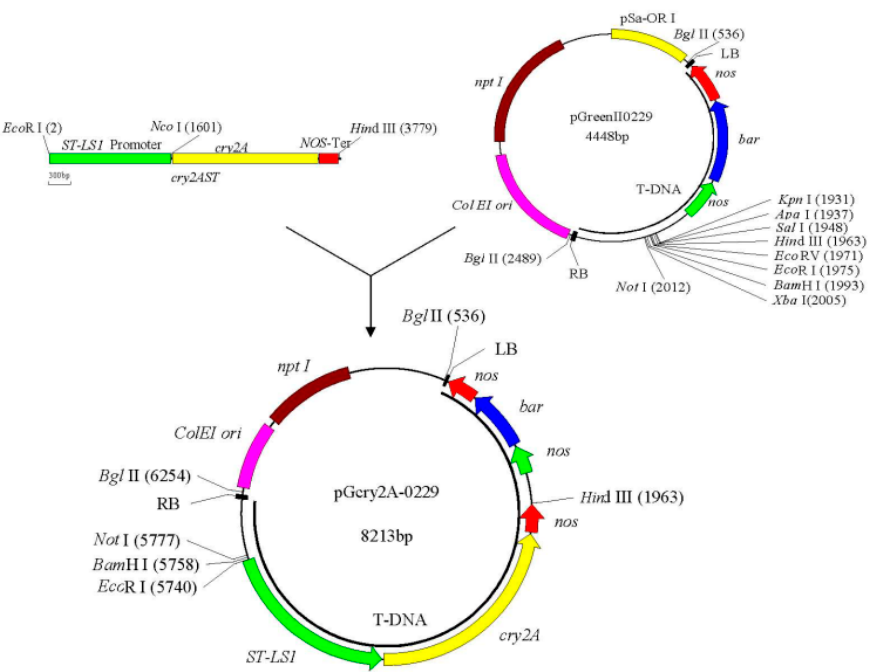
Figure 1. Construction roadmap of the plant expression vector pGcry2A0229.